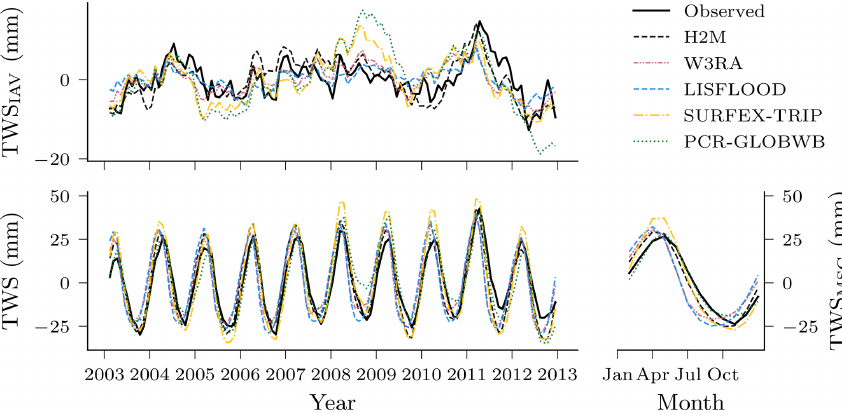
Figure 4. Comparison of the hybrid hydrological model (H2M) and a set of process-based global hydrological models (GHMs) of the terrestrial water storage (TWS), its mean seasonal cycle (TWS MSC ), and its interannual variability (TWS IAV ) for the global signal. The time series were aggregated using the cell-size-weighted mean across all grid cells. The regional time series are show in Appendix B, Fig.